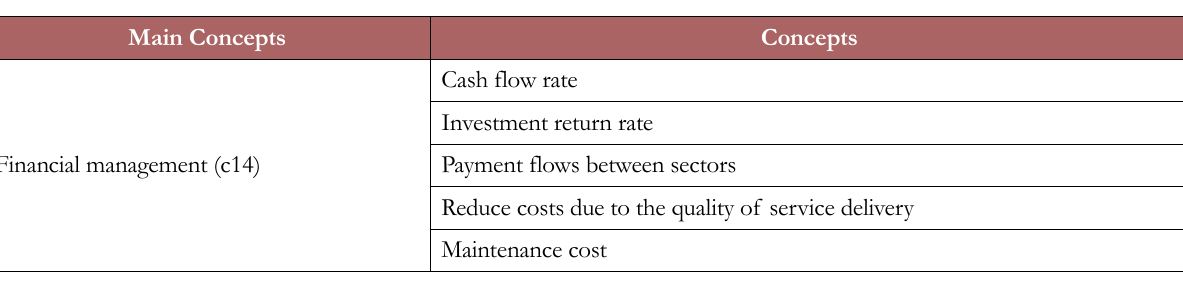
Table 3. Framework of hospital sustainable supply chain